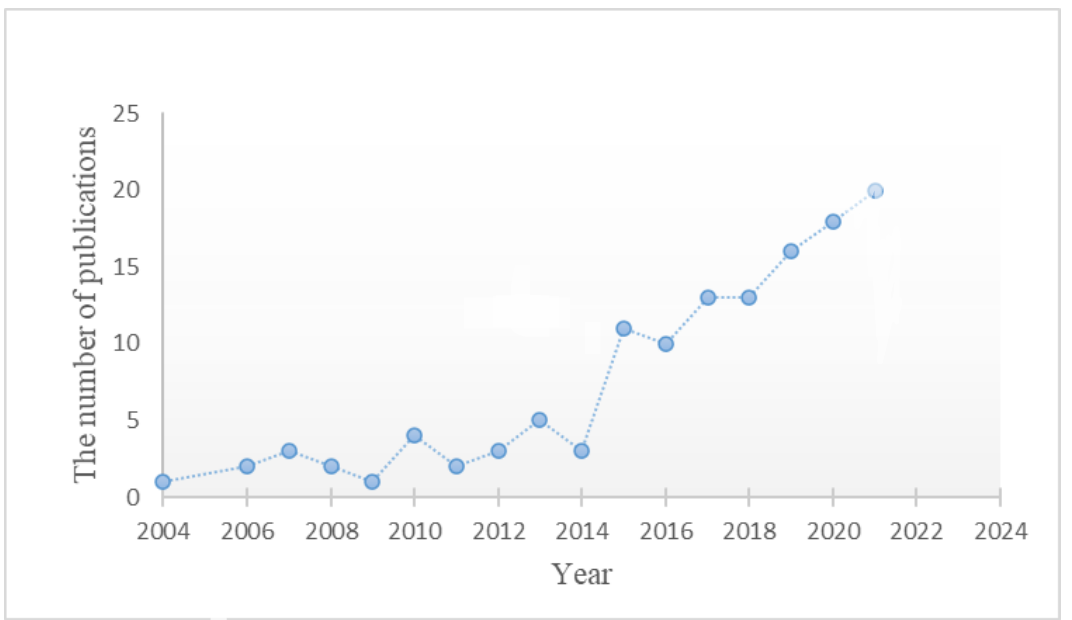
Figure 1. The number of publications on aptamers used as a diagnostic and therapeutic tool for breast cancer since 2004. Keywords included: “aptamer use”, “breast cancer”, “diagnosis”, and “therapy” aptamers’ .